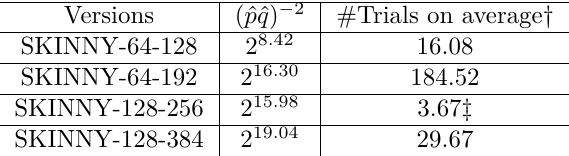
Table 11: Verification for distinguishers in Sect. 5 where distinguishers are reduce to two rounds.